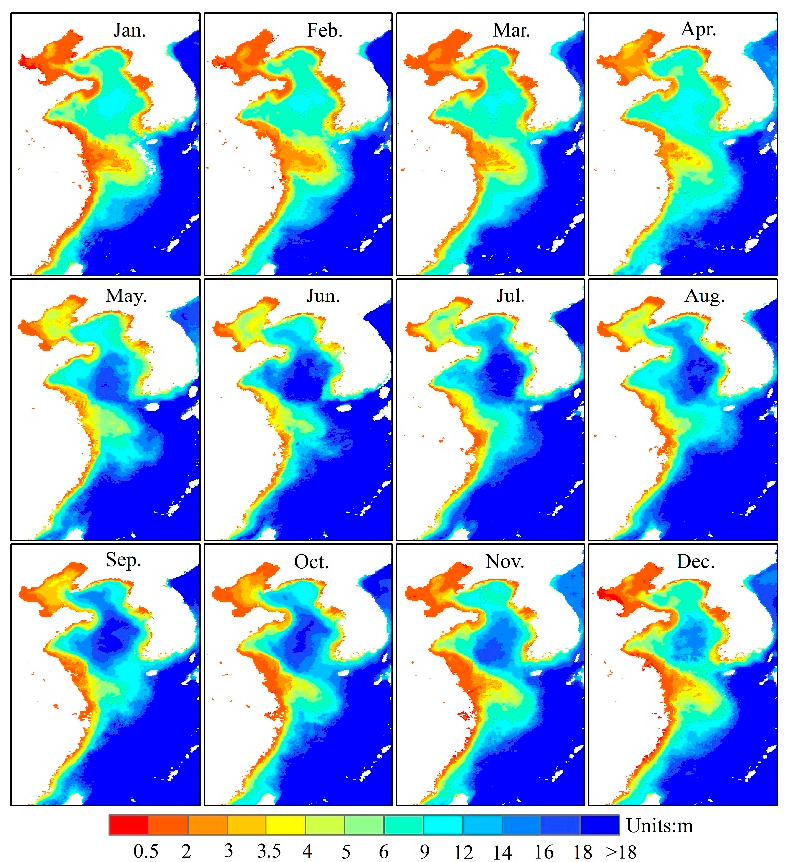
Figure 8. Climatology monthly and spatial change patterns of Z sd in CECZ seas derived from the MODIS daily R rs data during July 2002 to September 2014 following the NASA default data processing habits [41]. White color represents clouds or lands. All data within R rs (555) > 0.0 sr − 1 are included in the analysis.